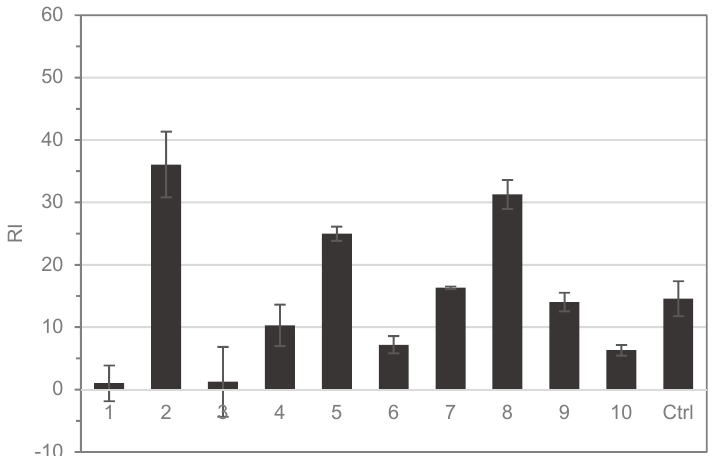
Figure 3. Structures of main constituents isolated from myrrh.